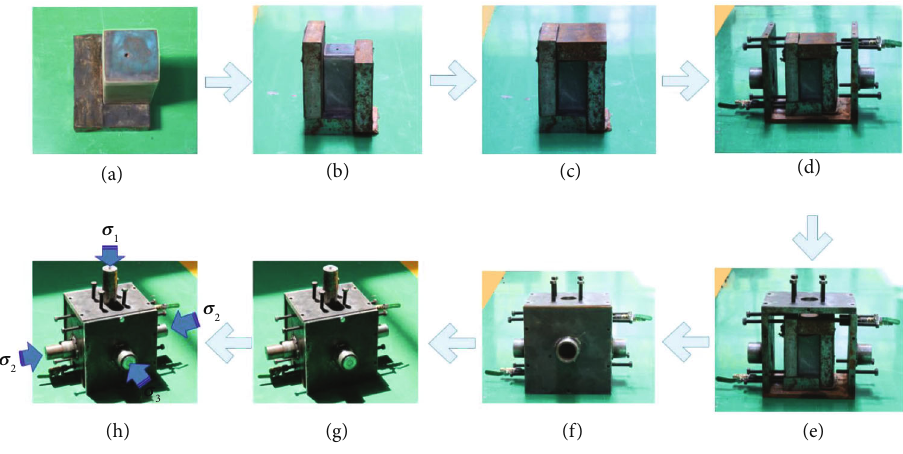
Figure 2: Equipment process of grouting test